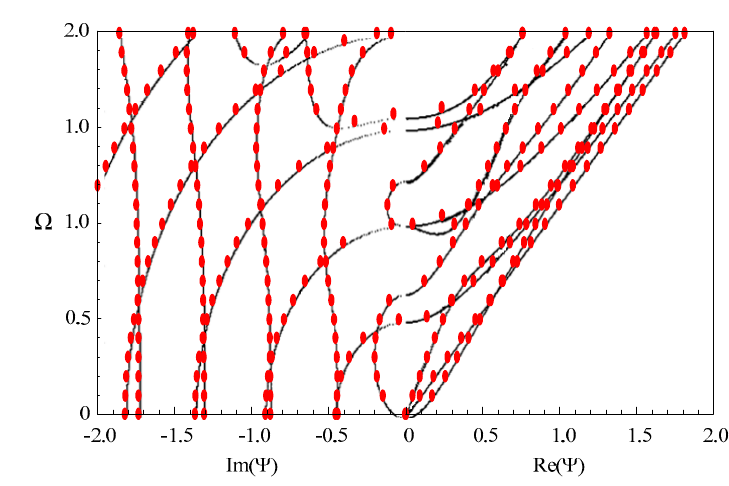
Figure 3. Dispersion curves of Lamb wave in a PZT-4 plate; red dots—our results, black dotted lines—literature results from the reverberation-ray matrix method.